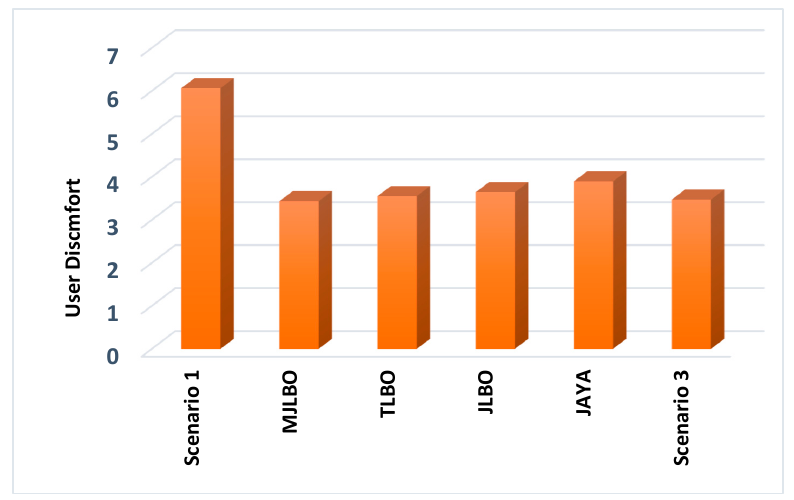
Figure 31. Percent PAR reduction of each MG for each scenario using MJLBO.